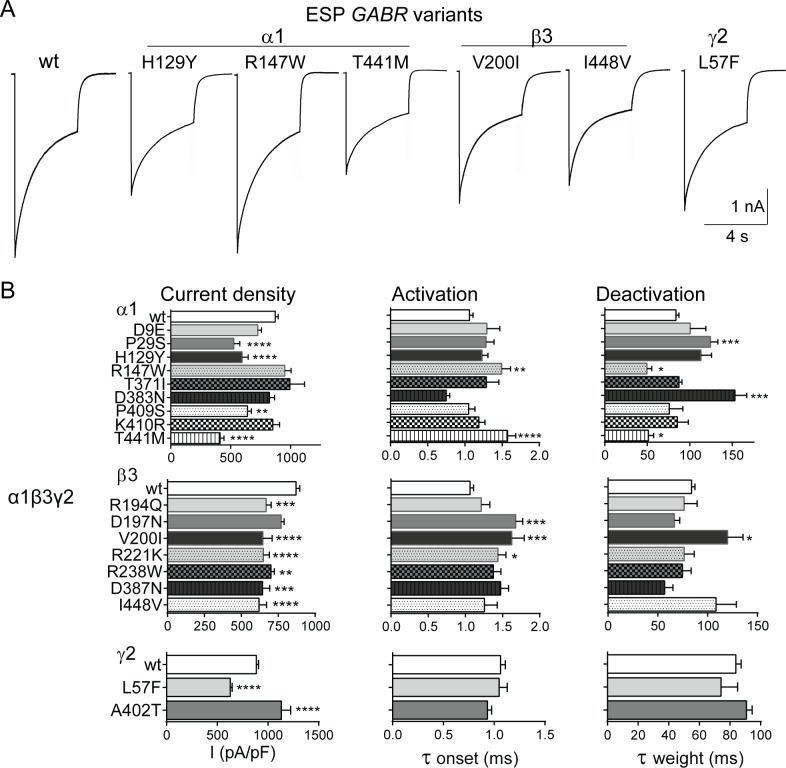
Deleterious ESP GABR variants caused major reductions of GABA-evoked currents.(A), Representative current traces from wild type (wt) and variant-containing receptors are presented. The variants α1H129Y, α1R147W, α1T441M, β3V200I, β3I448V, and γ2L57F were scored as deleterious by PolyPhen-2. GABA-evoked currents are the responses to 4 s pulses of 1 mM GABA on lifted cells expressing α1β3γ2 GABAA receptors. (B), Bar plots summarize the effects of wt and ESP subunit variants on macroscopic parameters of GABAA receptor currents. Current density was measured after 4 s pulses of 1 mM GABA, while activation and deactivation kinetics were measured after 10 ms pulses of 1 mM GABA. Values are expressed as mean ± S.E.M. *, **, *** and **** indicate p < 0.05, p < 0.01, p < 0.001 and p < 0.0001 respectively (one-way ANOVA with Dunnett’s multiple comparisons test) when compared to wt (see Table 4 for details).